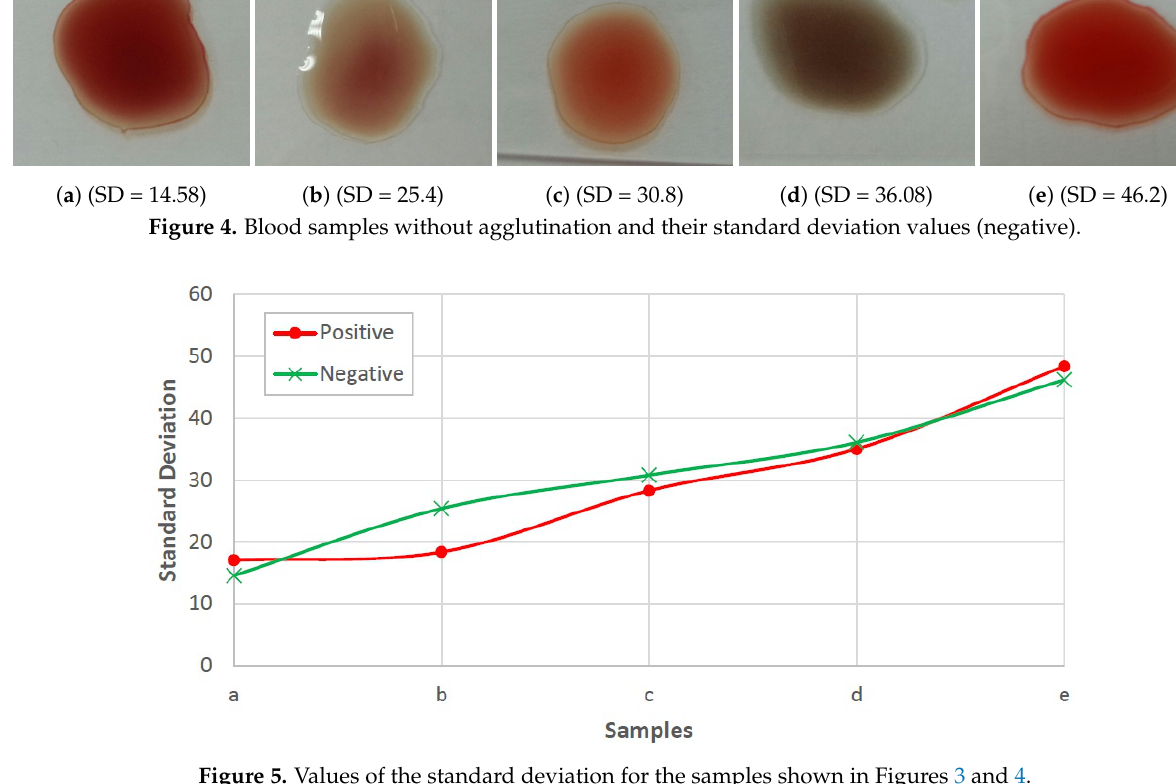
Figure 5. Values of the standard deviation for the samples shown in Figures 3 and 4.